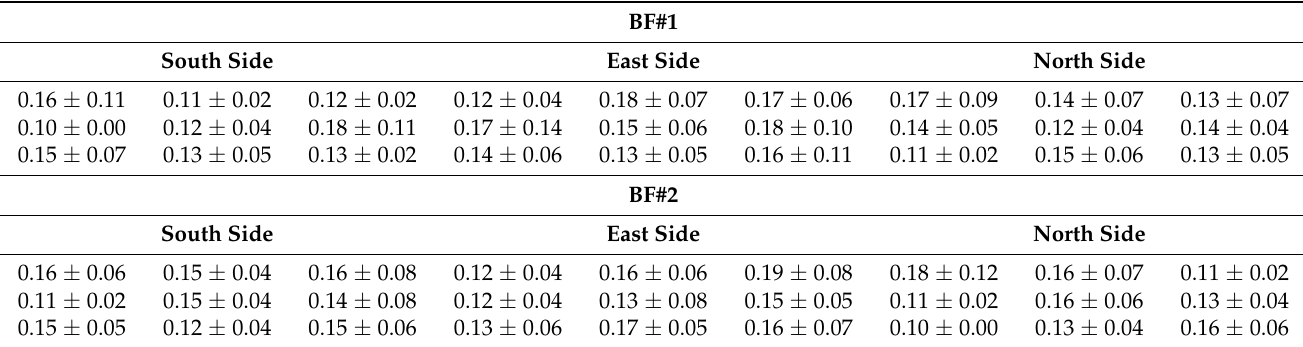
Table 1. Average air velocity (m/s) of each section over the entire monitoring period 1